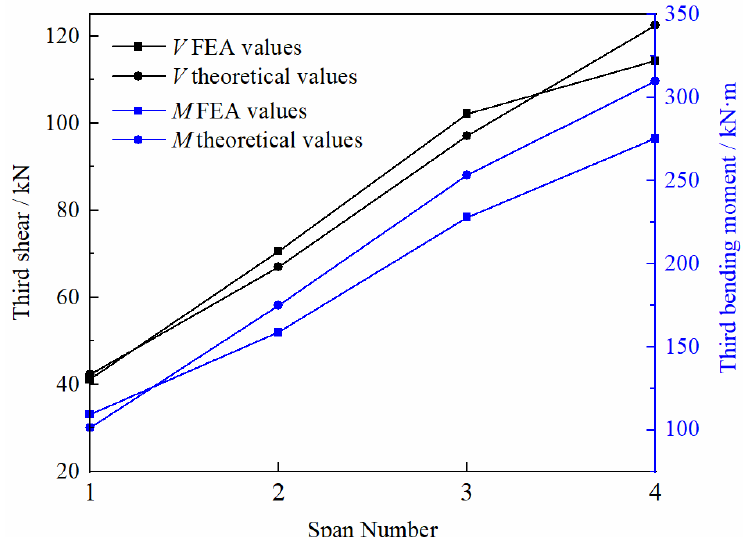
Figure 8. Relationship between span number and third shear and third bending moment.